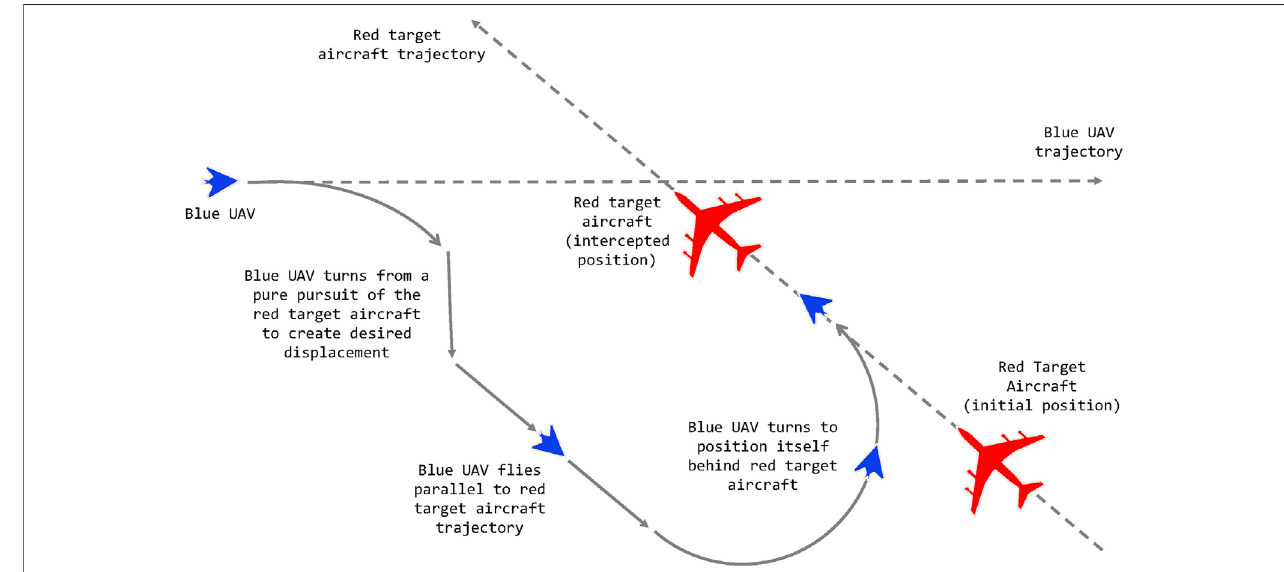
FIGURE 4 | A conceptual diagram of a blue UAV (the observer) performing a stern conversion maneuver with respect to a larger red aircraft. Reproduced with permission from Papasimeon and Benke (2021).